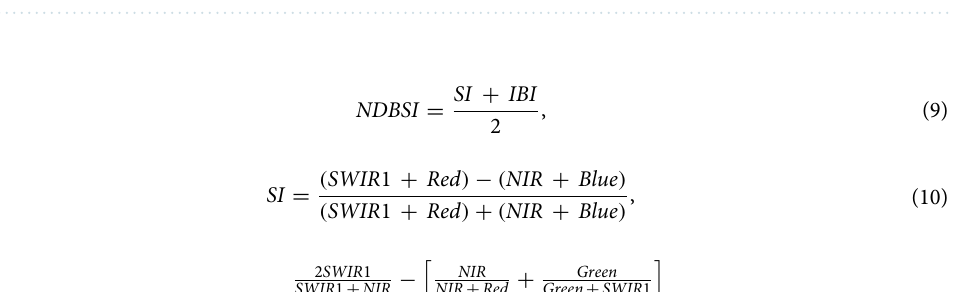
Table 2. Types of interaction between influencing factors.